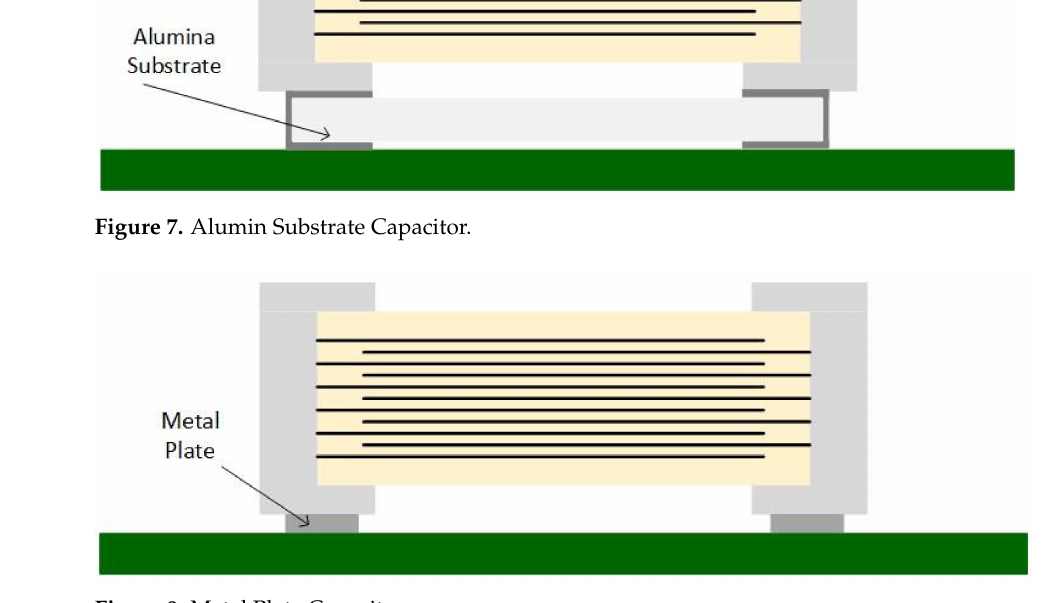
Figure 8. Metal Plate